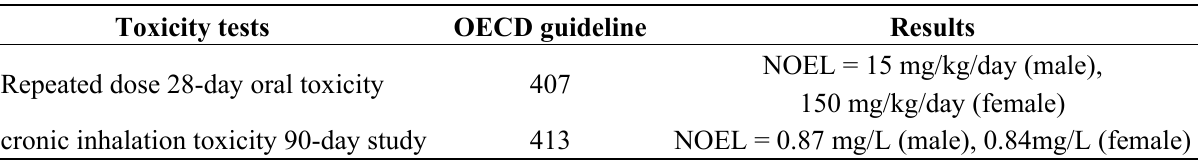
Table 2. The repeated toxicity studies of